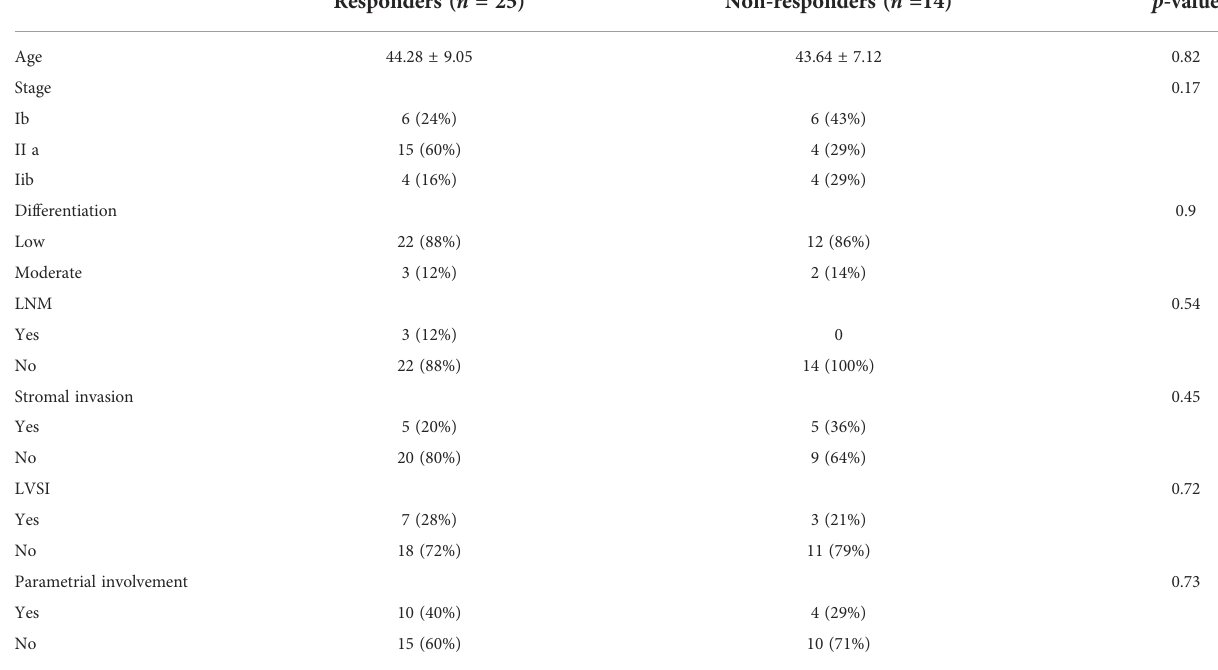
TABLE 2 The clinical characteristics of SCC